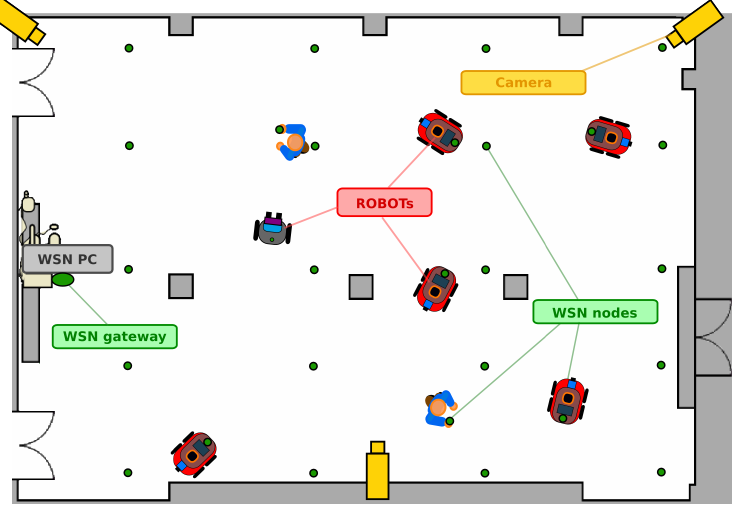
Figure 1. General scheme of the integrated